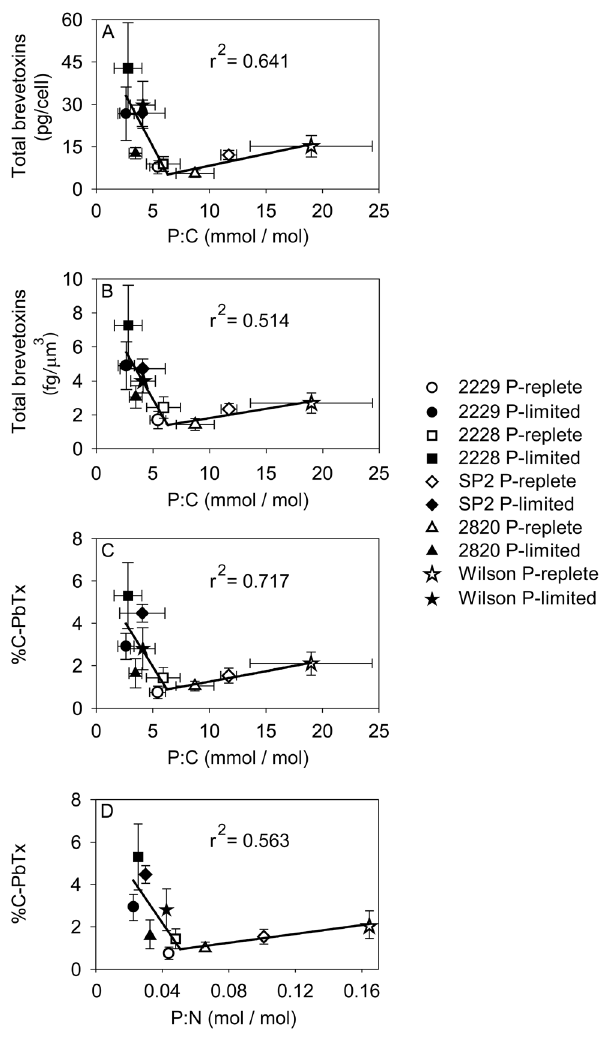
Figure 6. Relationships between cellular brevetoxins and P:C and P:N ratios. (A) Total brevetoxin per cell (pg/cell) vs. P:C ratio (mmol/mol), (B) Total brevetoxins normalized to cell volume (fg/ m m 3 ) vs. P:C (mmol/mol), (C) Percent of total cell carbon present as brevetoxins (%C-PbTx) vs. P:C (mmol/mol), and (D) Percent of total cell carbon present as brevetoxins (%C-PbTx) vs. P:N (mol/mol). Error bars represent standard deviations of triplicate measurements for both x and y values, except those normalized to carbon, where the cellular C was measured only in duplicate. Data from P-replete and P-limited cultures are indicated by open and filled symbols, respectively. Two segment piecewise linear regressions were fit to the data in each panel using the SigmaPlot H 11.2 graphical analysis